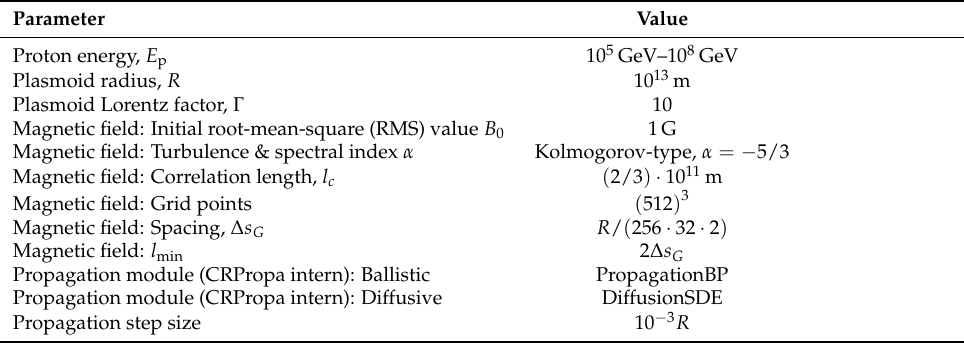
Table 2. Simulation parameters, given in the rest frame of the plasmoid. All simulations are performed in a modified version of CRPropa 3.1 as presented in Hörbe et al. in [19] with further additions made for this paper as described above.